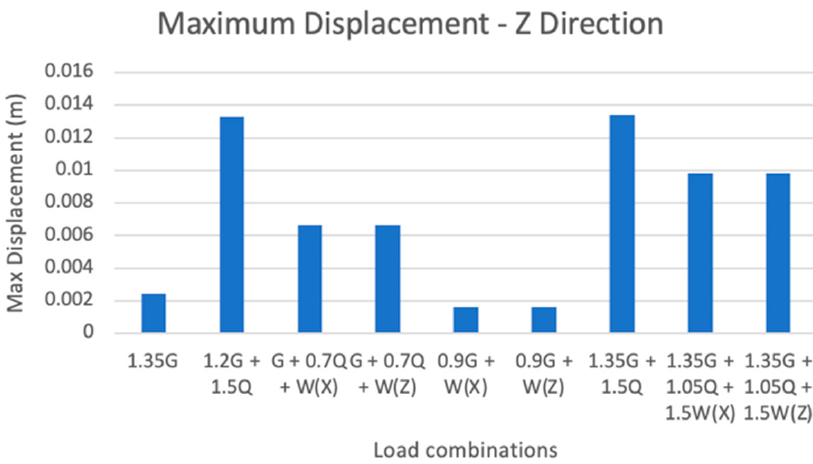
Figure 19. Maximum vertical displacement of the floor for each load combination.